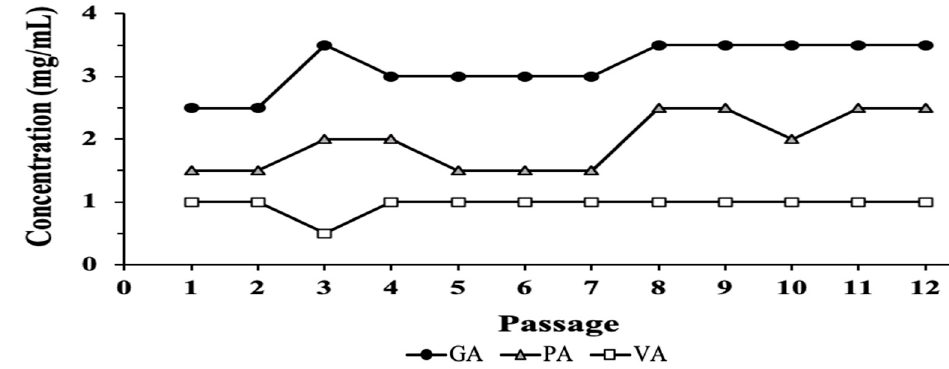
Figure 2. Evaluation of changes in susceptibility of ST individually treated with GA, PA and VA over 12 generations.